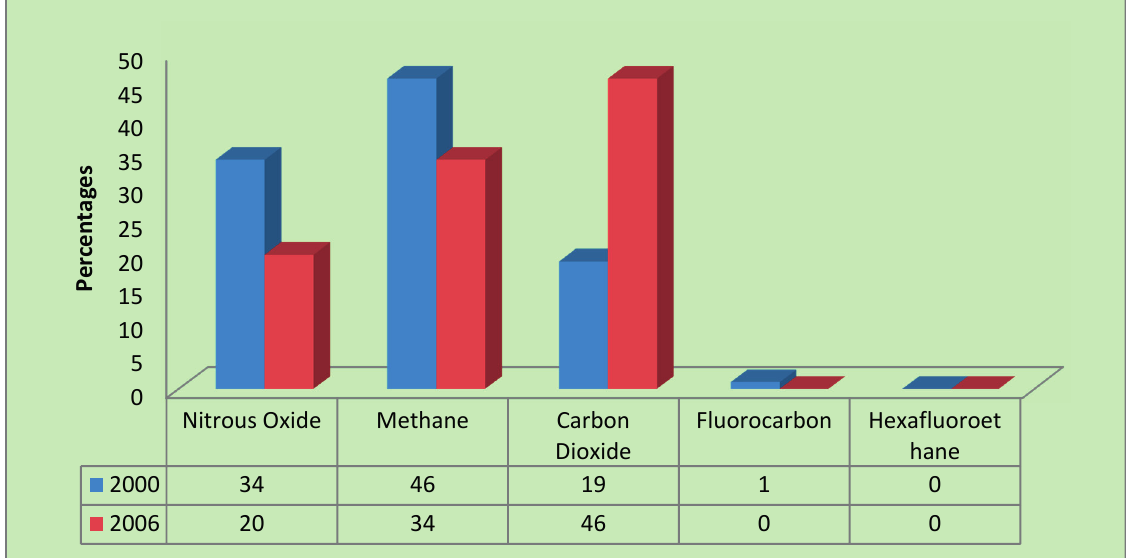
Figure 1. Components of Greenhouse Gases. Source: Author’s compilation from